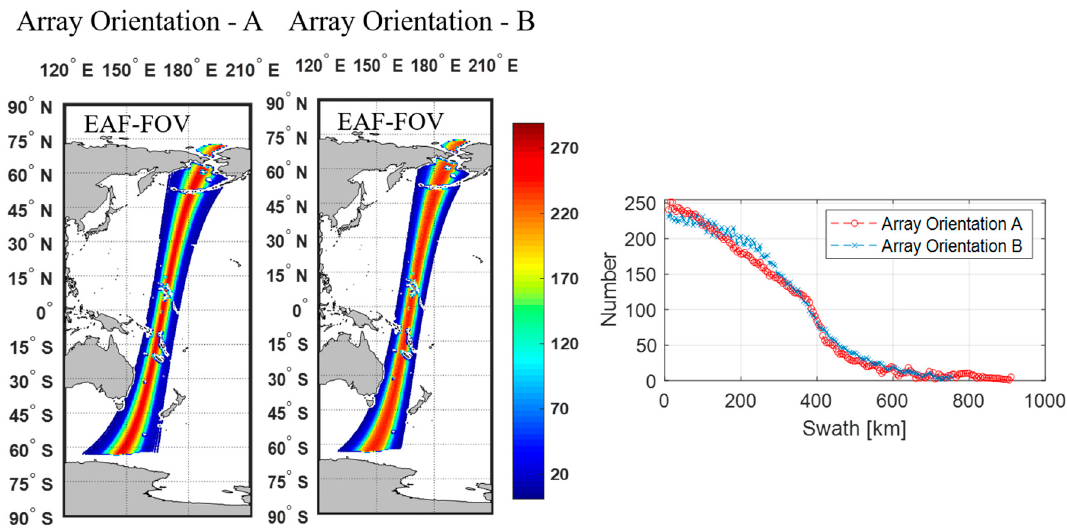
Figure 10. Illustration of the numbers of the repeated measurements in 25 km EASE grid when using the EAF-FOV for simulation. The color maps in the left present the distributions of the numbers measured along orbit for two di ff erent array orientation. The plots in the right show the variations of the numbers versus the distance to the swath center for two di ff erent array